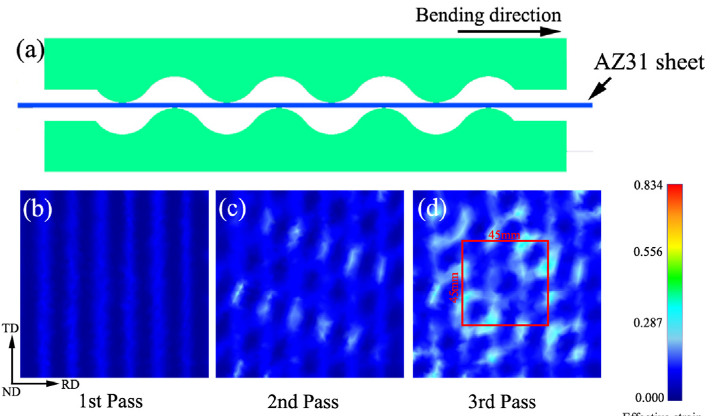
Figure 1. ( a ) Schematic illustration of the device for cross-wavy bending; ( b )–( d ) finite element simulation of wavy bending at room temperature: effective strain contour plot of deformed sheets at different steps, corresponding to ( b ) the 1st pass bending along the rolling direction (RD), ( c ) 2nd pass bending along 45°, and ( d ) 3rd pass bending along the transverse direction (TD). The marked area with 45 mm × 45 mm is cut for the Erichsen test.